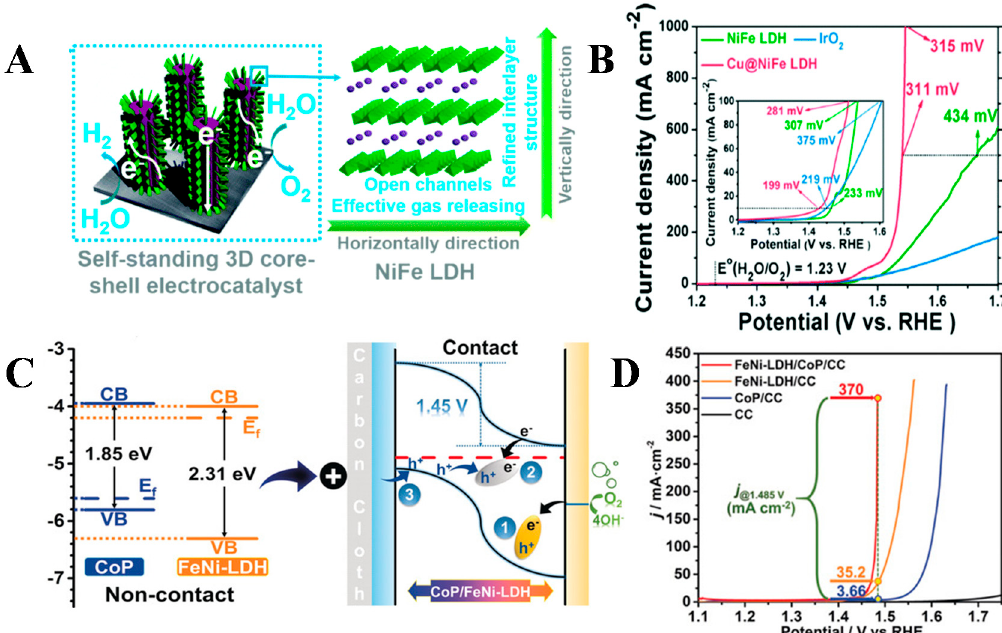
Figure 13. ( A ) Schematic illustration of the fabrication procedure of the self-standing 3D core–shell Cu@NiFe-LDH electrocatalysts; ( B ) OER performance of Cu@NiFe-LDH conducted in 1 M KOH [181]. Copyright © The Royal Society of Chemistry 2017. ( C ) The energy diagrams of CoP and FeNi-LDH and the proposed mechanism for electrocatalyzing OER in the FeNi-LDH/CoP/CC p-n junction under the condition of applying enough potential via the external circuit; ( D ) LSV curves toward OER in 1 M KOH electrolyte at a scan rate of 5 mV s − 1 [183]. Copyright © 2019 Wiley-VCH Verlag GmbH & Co. KGaA, Weinheim.